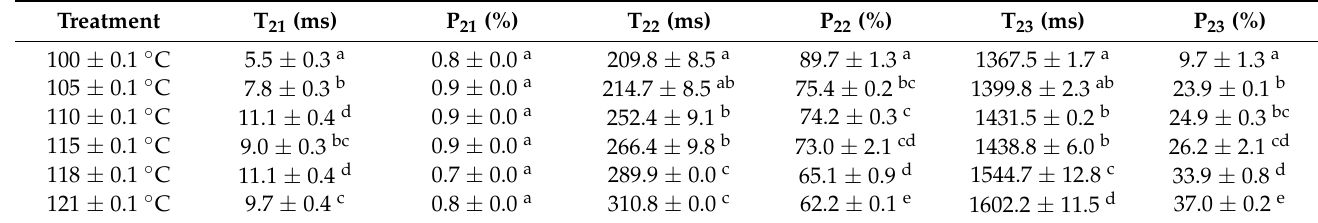
Table 1. Transverse relaxation time and proportion of peak area.